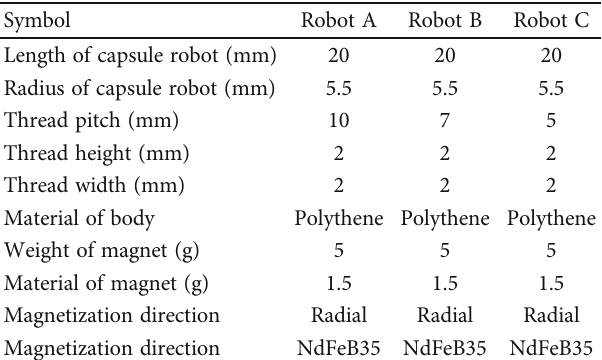
Table 1: Capsule robot main parameters.